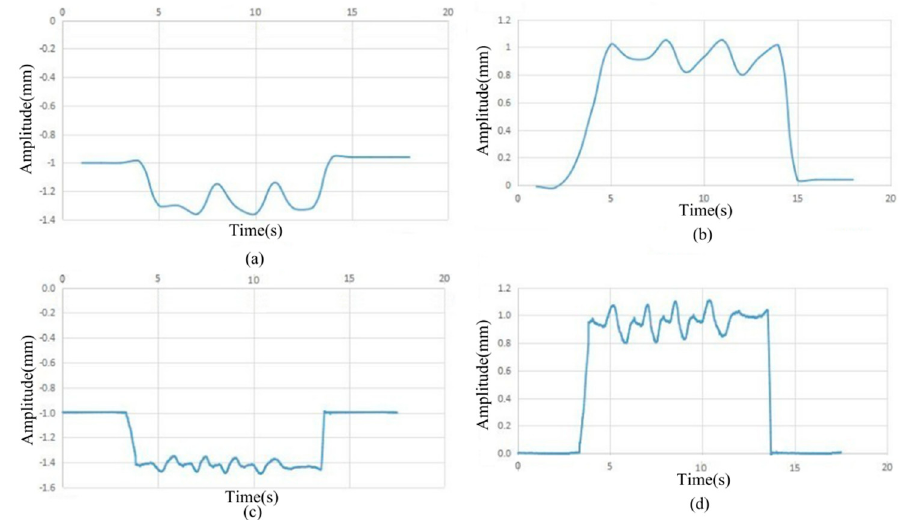
Figure 8. Comparison of experimental data. ( a , c ) time domain variation in the collected gap data display of the data collected using KingView; ( b , d ) time domain variation in the collected gap data display of the data collected using the system.